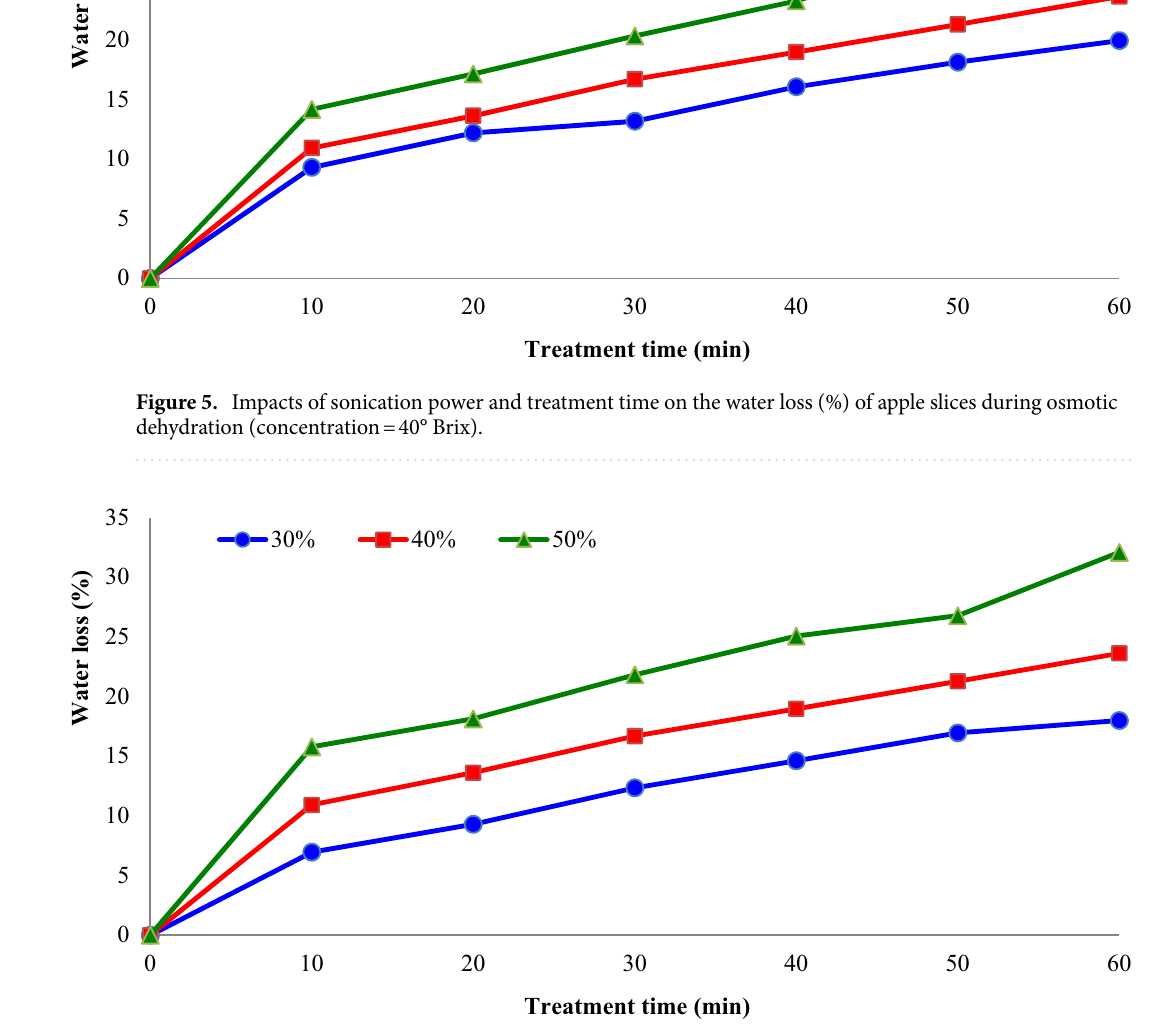
Figure 6. Impacts of sucrose solution concentration (°Brix) and treatment time on the water loss (%) of apple slices during osmotic dehydration (sonication power = 75